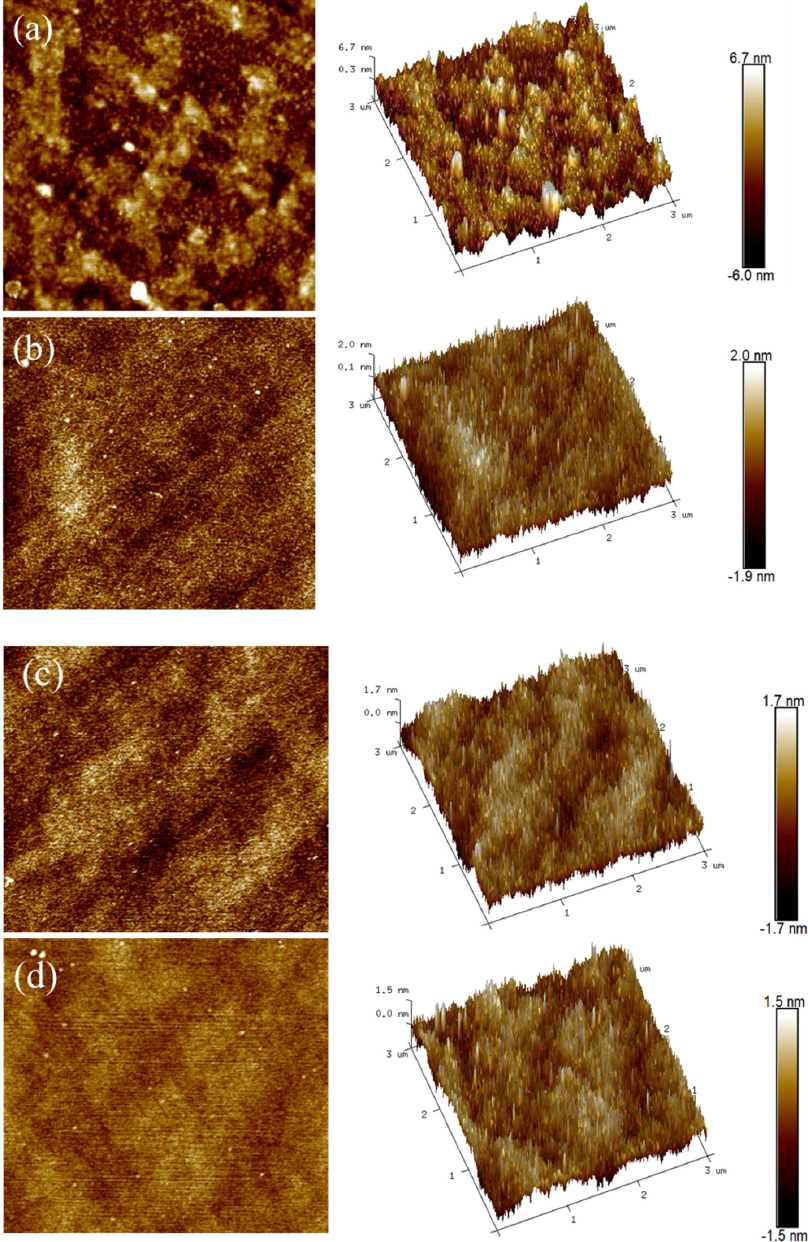
Figure 3. Surface roughness 2D and 3D AFM images of Ta 2 O 5 coatings were prepared under different sputtering gas conditions. ( a ) 40Ar, ( b ) 36Ar–4N 2 , ( c ) 34Ar–6N 2 , ( d ) 32Ar–8N 2.